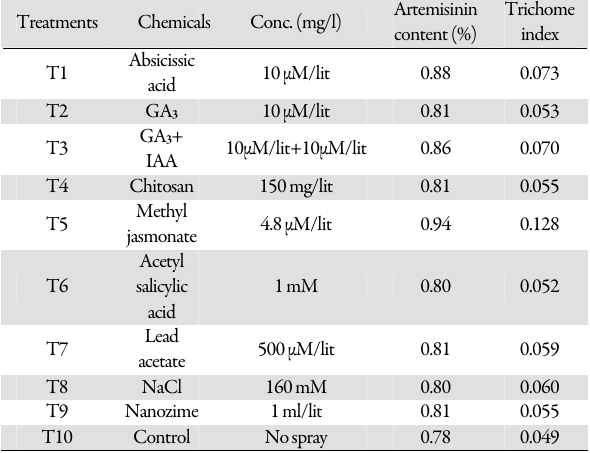
Tab. 1. Effect of growth regulators on artemisinin content and trichome index of A.